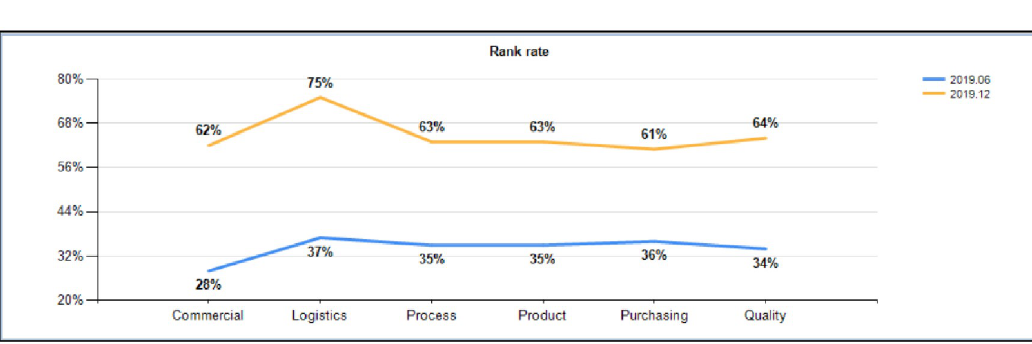
Fig 12. Post functional task efficiency ratios (2019.6 VS 2019.12).